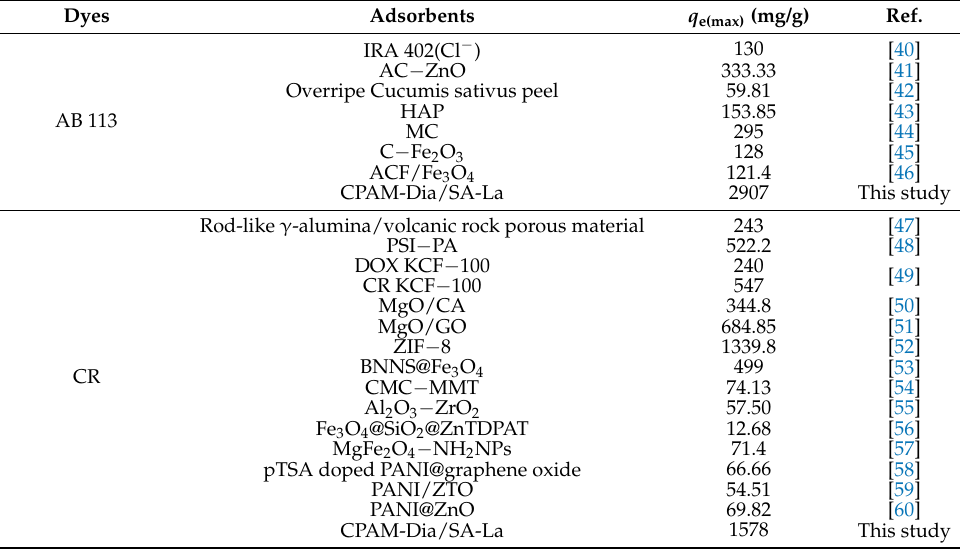
Table 3. Maximum adsorption capacities of AB 113 and CR on various